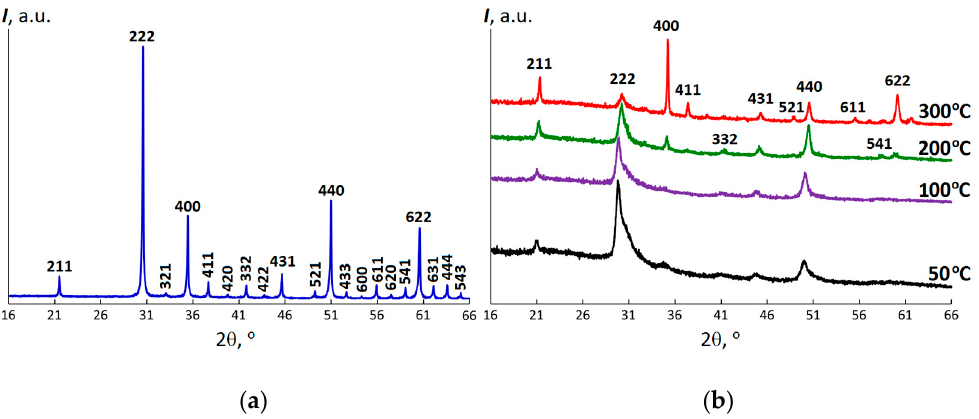
Figure 3. ( a ) XRD pattern of the ITO ceramic target source; ( b ) XRD patterns of the ITO thin films deposited at various substrate temperatures. All peaks and temperatures have been labeled.